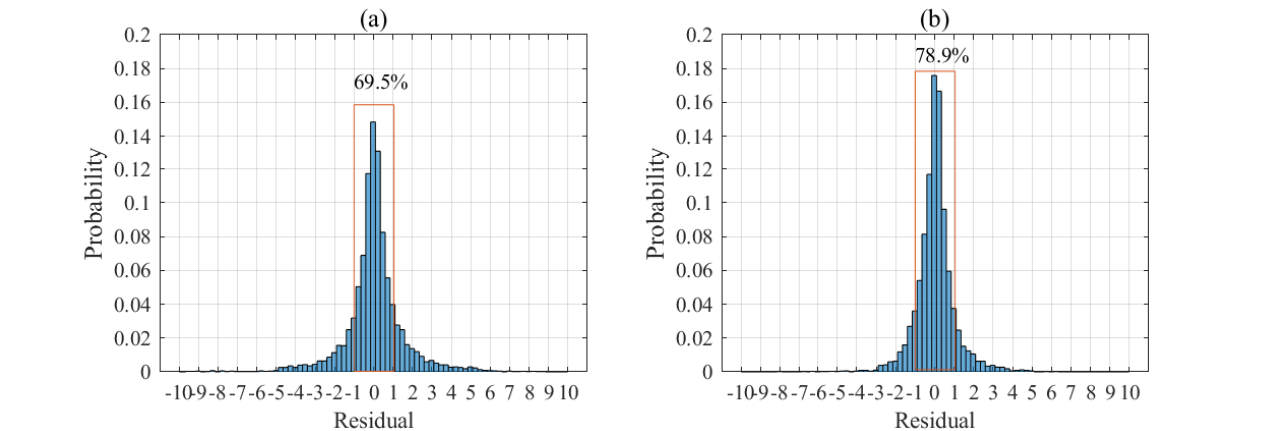
Figure 8. Overall residual distributions of the LSTM − AM model ( a ) and LSTM − AM − MLP model ( b